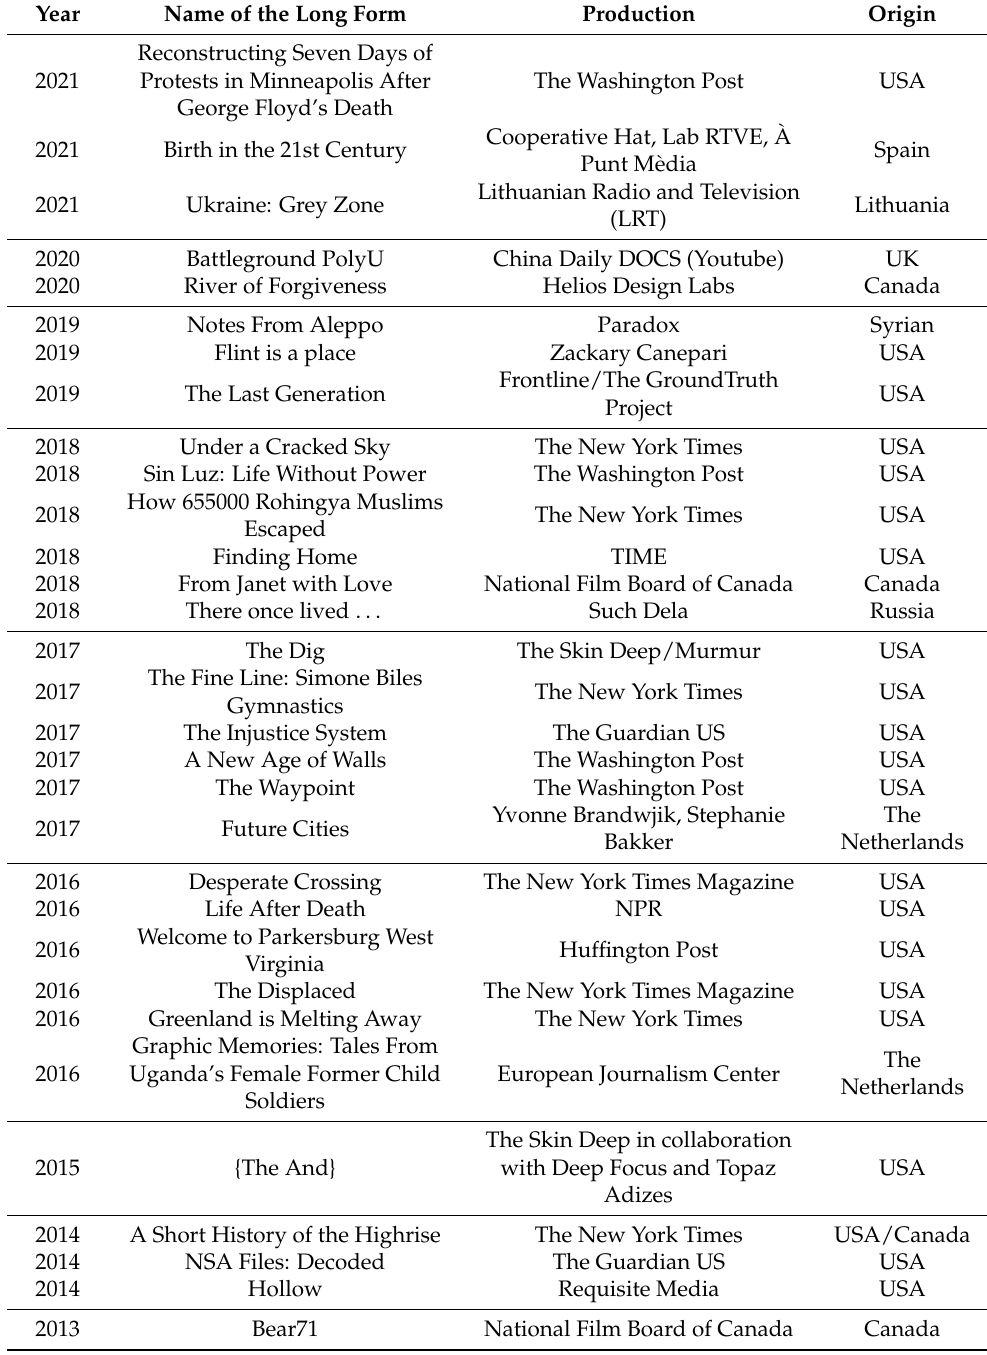
Table 2. Overview of the story